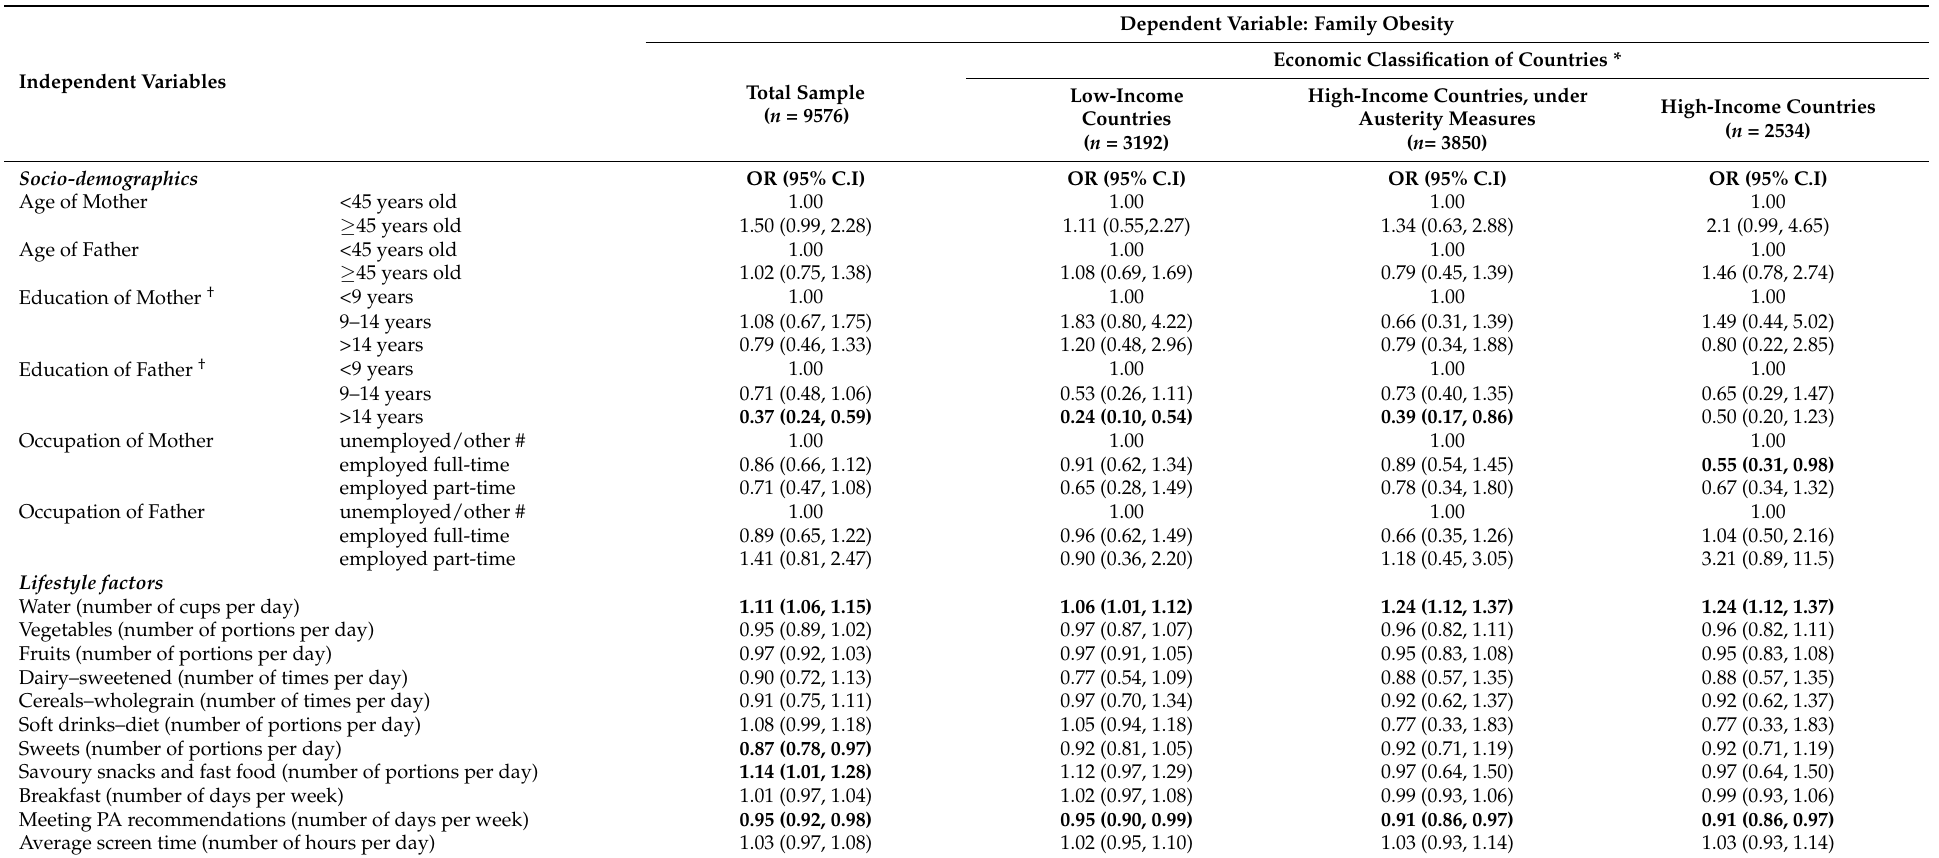
Table 5. Multivariate logistic regression analyses examining the associations between sociodemographic characteristics, lifestyle factors, and family obesity for the total sample and by country’s economic